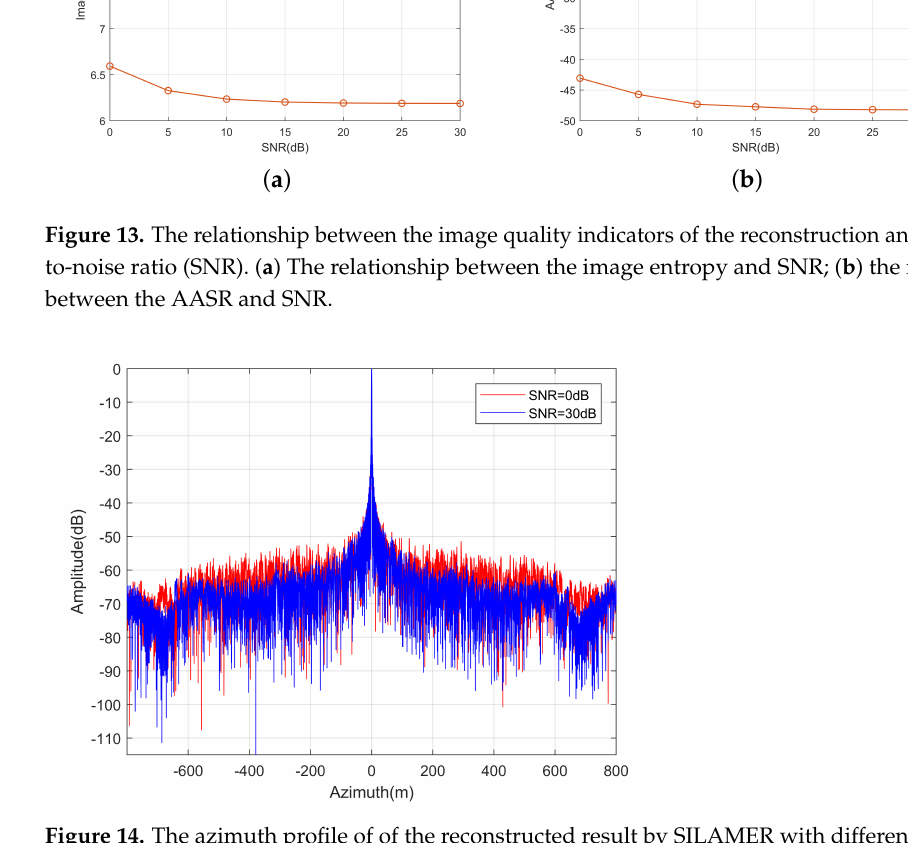
Figure 14. The azimuth profile of of the reconstructed result by SILAMER with different